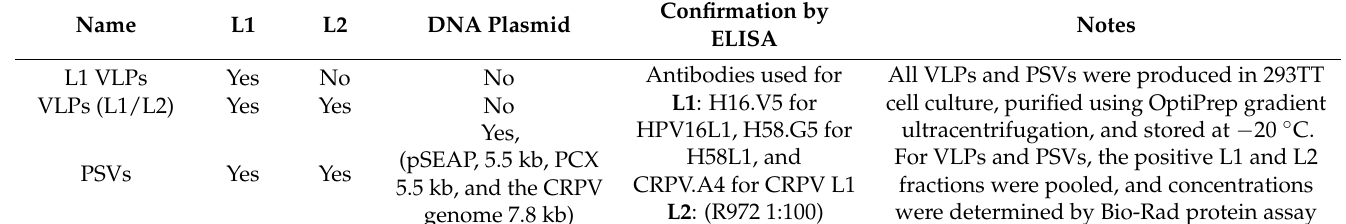
Table 1. Viral particles (VLPs) and pseudoviruses (PSVs) used in the current study.